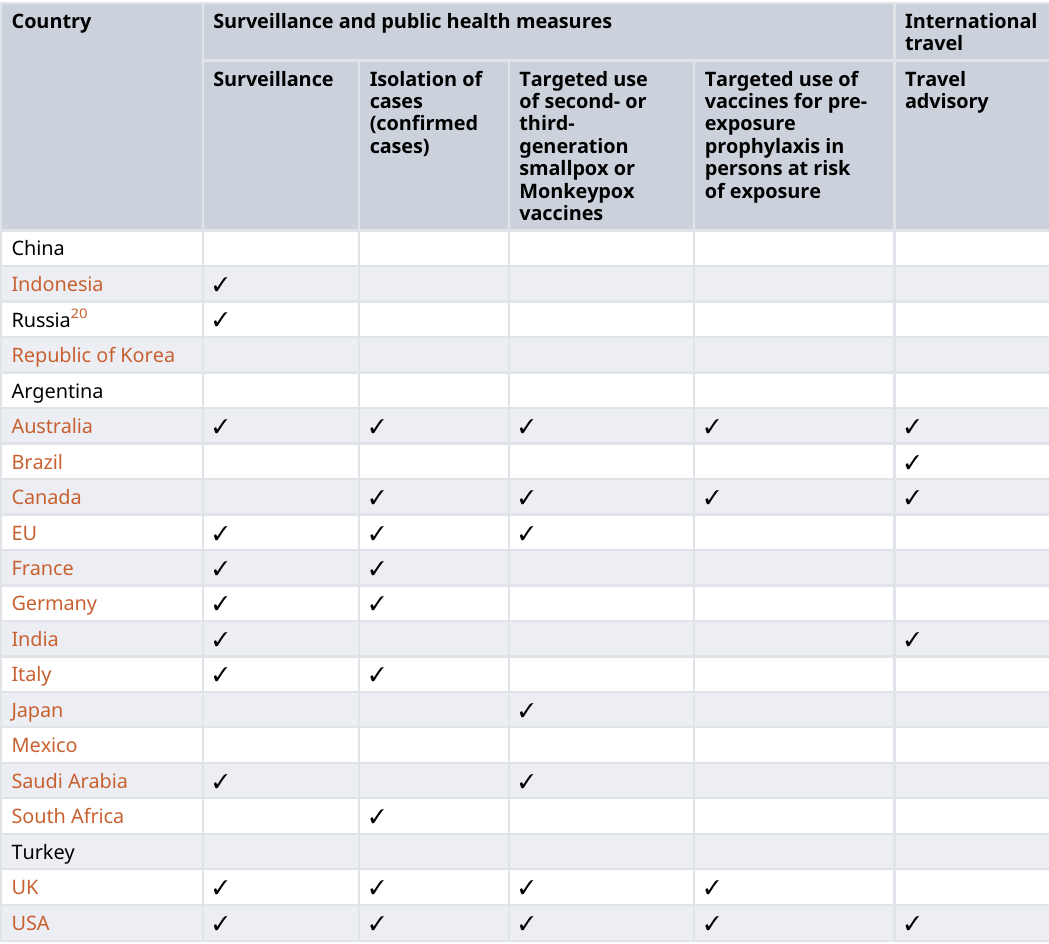
Table 4. Surveillance and public health measures and international